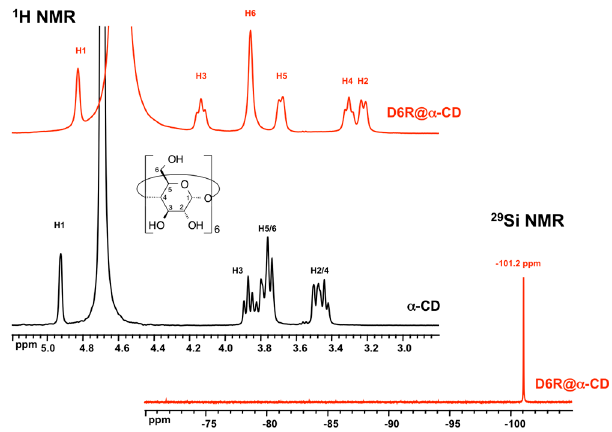
Figure 2. 1 H and 29 Si NMR spectra of D6R@ α -CD (15 mM in 3 M KCl D 2 O, pD = 12.7). For comparison, the spectrum of a solution of α -CD (30 mM in D 2 O) is also shown.